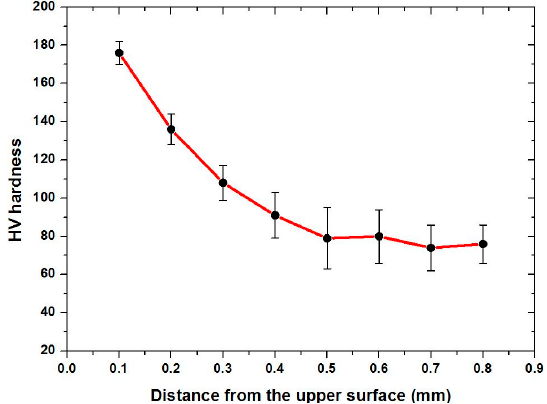
Figure 11. Schematic diagram of hardness as distance from the upper surface.